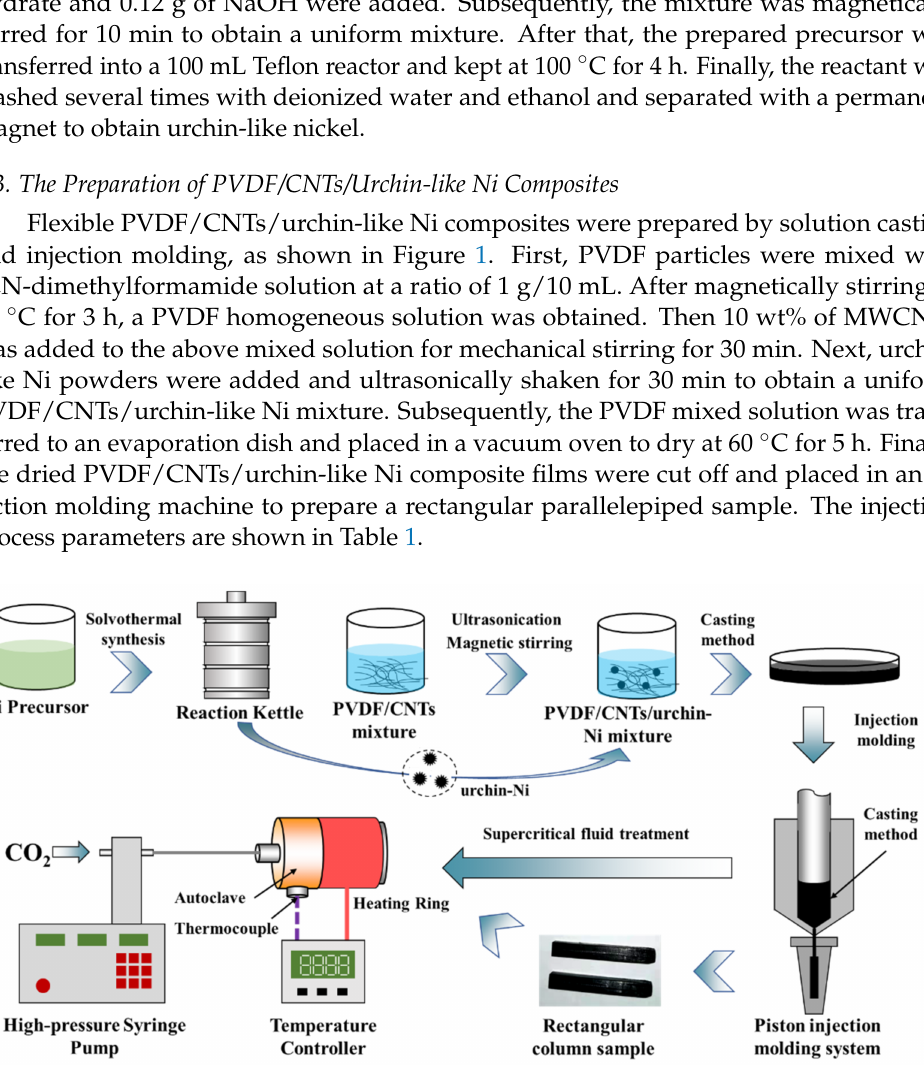
Figure 1. The preparation processing of PVDF/10 wt% CNTs/10 wt% urchin-like Ni compo-site